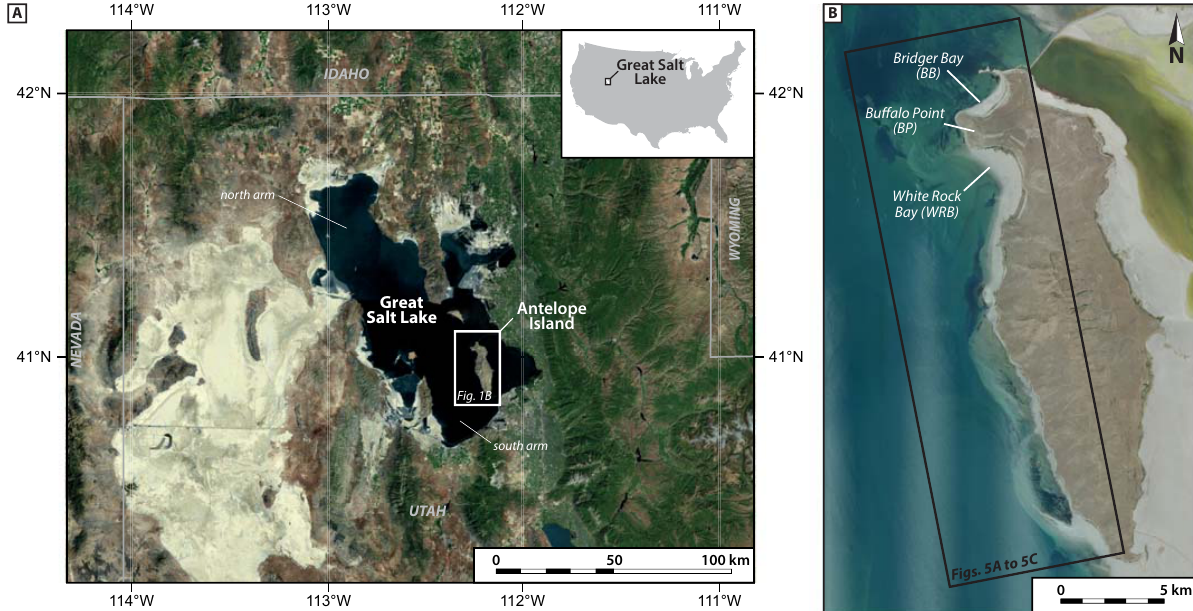
Figure 1. Satellite images of the Great Salt Lake (a) and Antelope Island (b) showing the studied localities: Bridger Bay (BB), Buffalo Point (BP) and White Rock Bay (WRB). The satellite images are provided by Flashearth (with Bing maps; Microsoft Corporation-Imagery © Harris Corp, Earthstar Geographics LLC) and the Utah Automated Geographic Reference Center (2014 NAIP 1 Meter